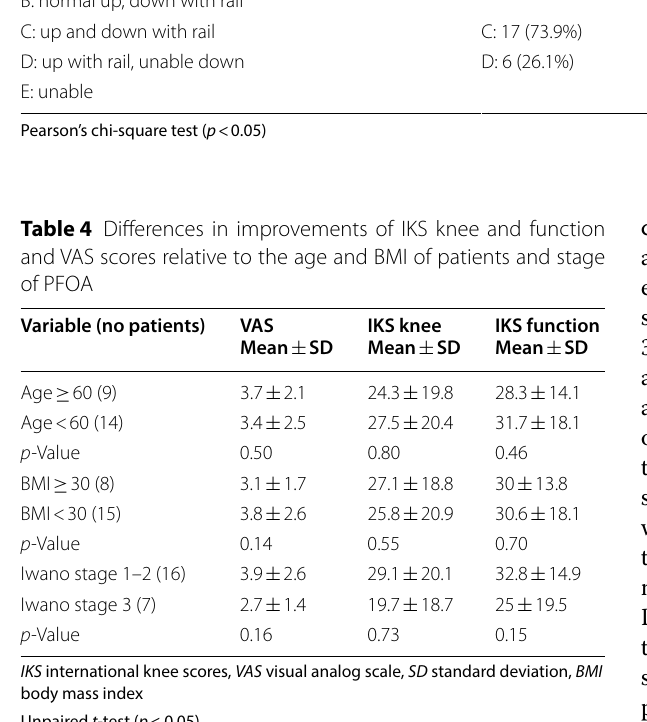
IKS international knee scores, VAS visual analog scale, SD standard deviation, BMI body mass index Unpaired t -test ( p <